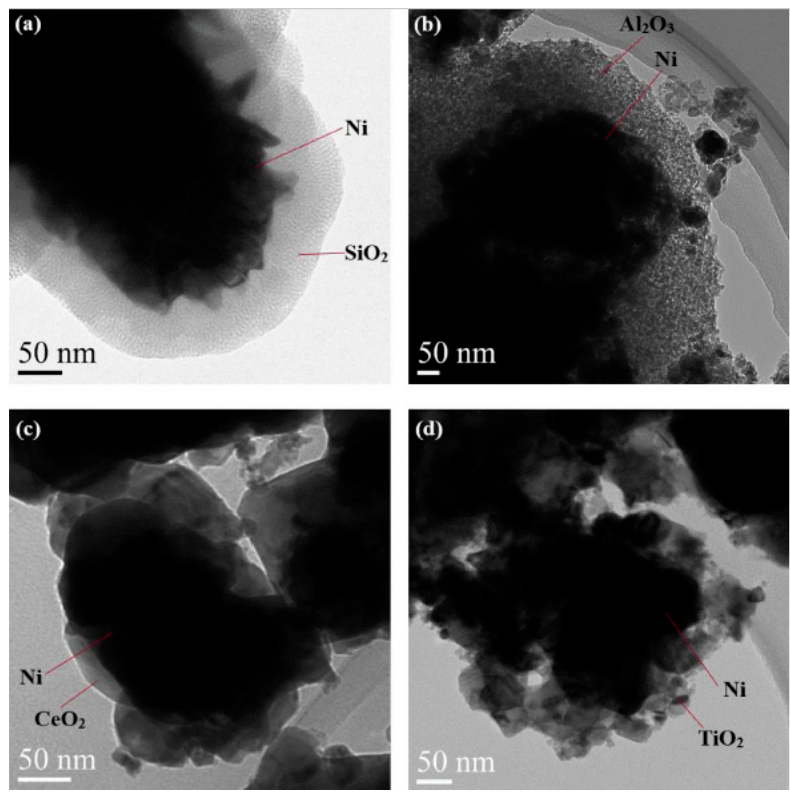
Figure 15. TEM images of the core-shell catalysts reduced at 600 °C: ( a ) Ni/iO 2 , ( b ) Ni/Al 2 O 3 , (c) Ni/CeO 2 , and ( d ) Ni/TiO 2 . Reprinted with permission from Ref. [201]. Copyright 2022 Elsevier.